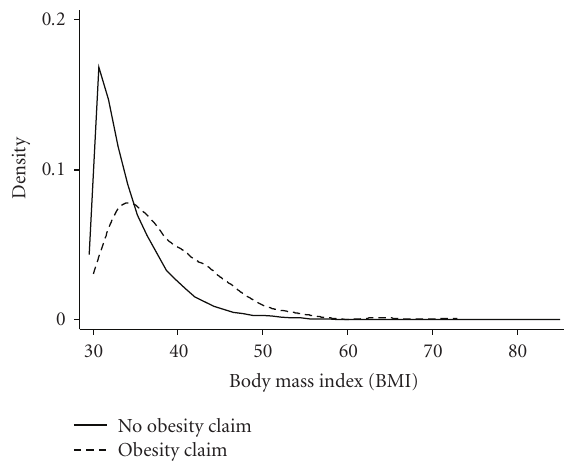
Figure 1: BMI in obese study sample for persons with and without an obesity claim. Note that obesity was defined as a body mass index, BMI ≥ 30kg/m 2